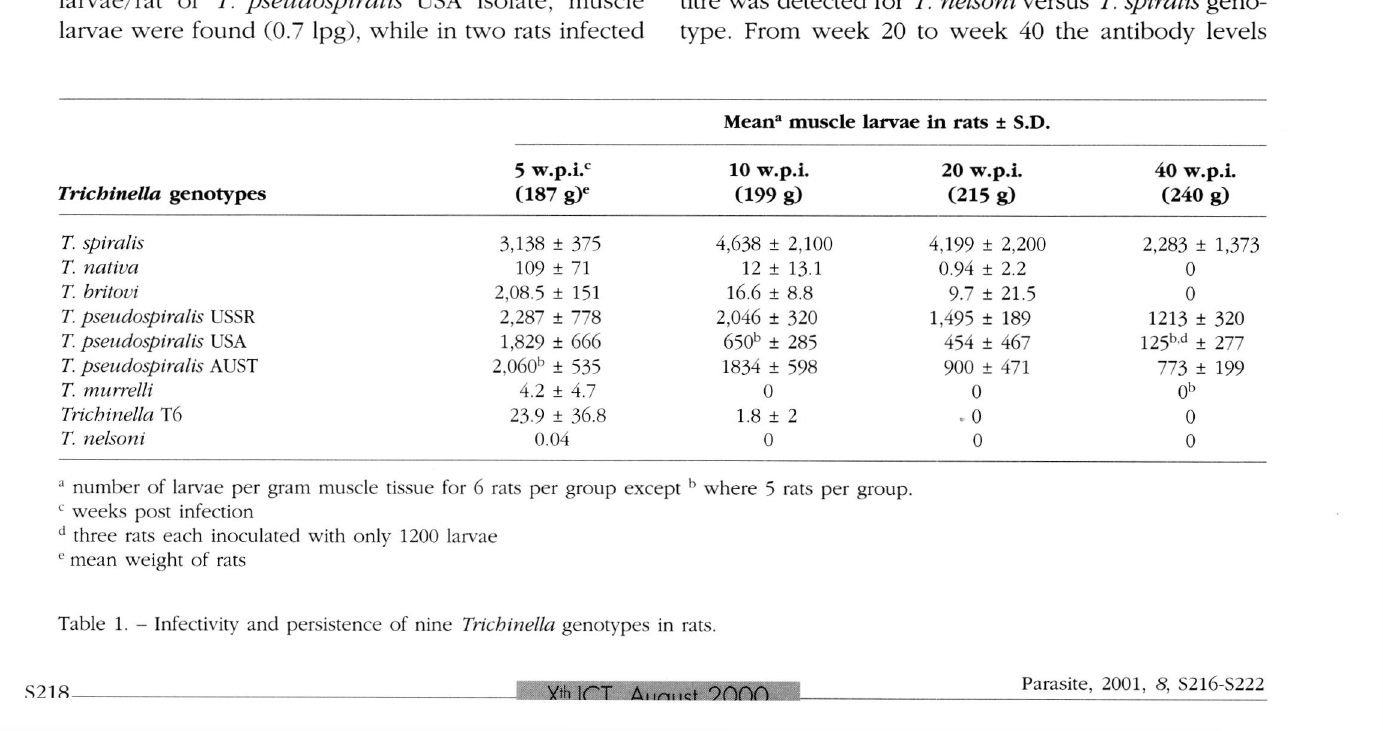
Table 1. - Infectivity and persistence of nine Trichinella genotypes in rats.